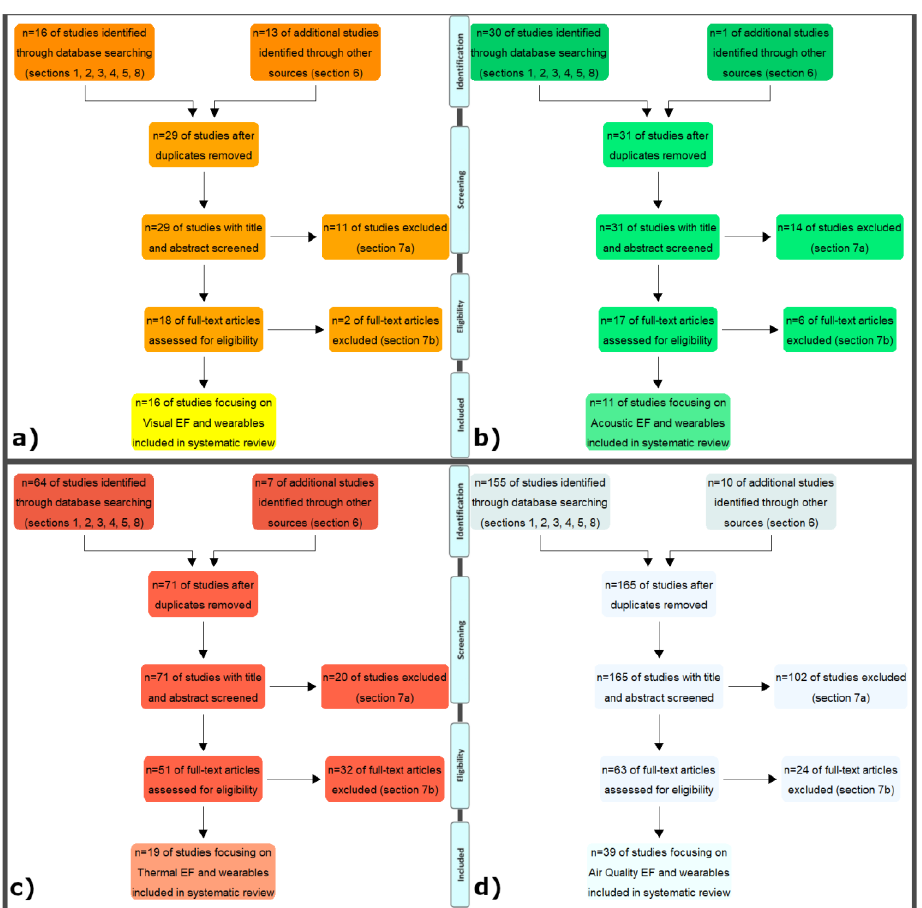
Figure 3. PRISMA flow diagrams: ( a ) Visual EF; ( b ) Acoustic EF; ( c ) Thermal EF; ( d ) Air Quality EF. The number of sections refers to query structure (Figure 2).